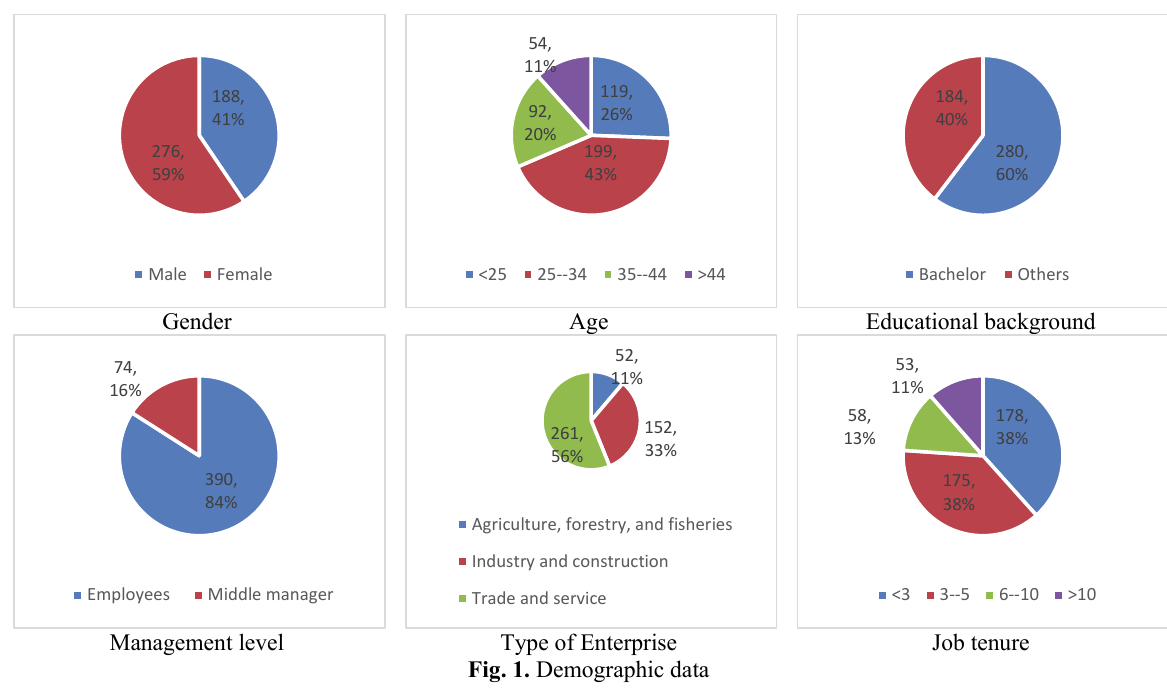
Fig. 1. Demographic data